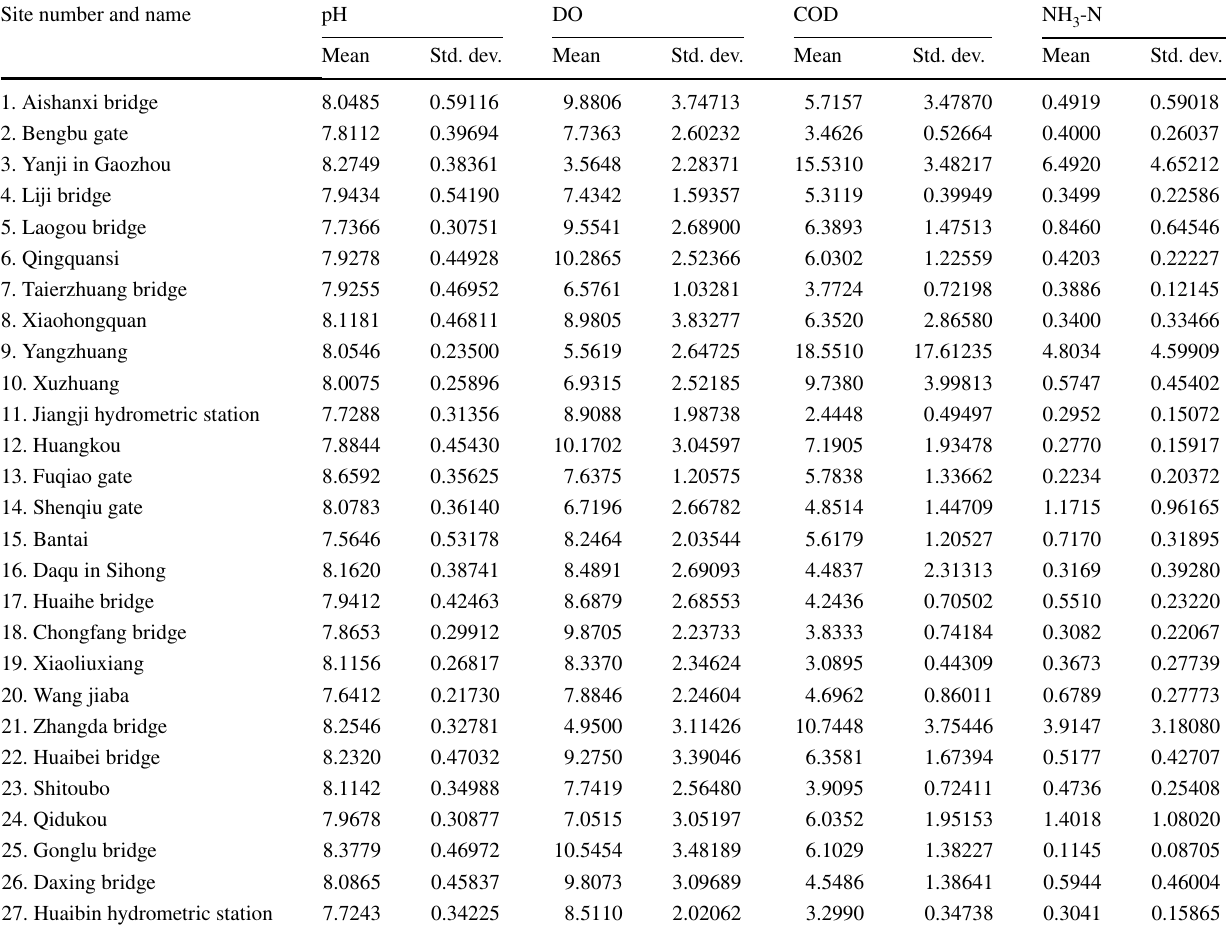
Site number and